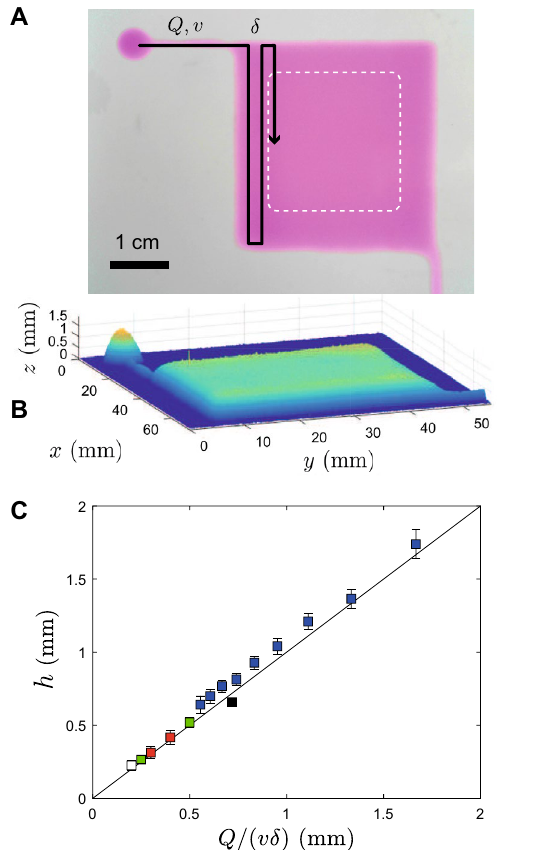
Figure 4. ( A , B ) A continuous flat film can be printed upon proper overlap of the lines; the thickness of the deposit is measured by averaging the data points collected in the white dotted area in ( A ), and depends on a simple combination of the printing parameters Q , v , and δ ( C , different colours of symbols correspond to different sets of printing parameters). The straight line has a slope of